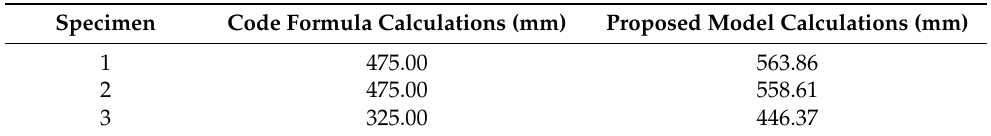
Figure 12. Effective beam width prediction in the current RC Standard. Table 3. Comparison of the effective beam